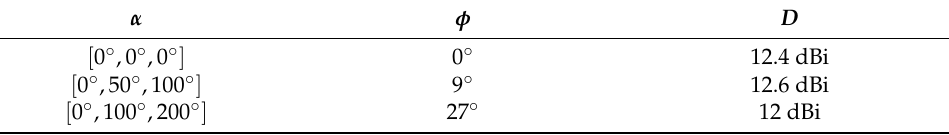
Figure 7. Cut in xy plane of simulated and measured radiation patterns for tested combinations of phases α of excitation signals of equal magnitudes at the frequency of 26 GHz: ( a ) [ 0 ◦ ,0 ◦ ,0 ◦ ] , ( b ) [ 0 ◦ ,50 ◦ ,100 ◦ ] , and ( c ) [ 0 ◦ ,100 ◦ ,200 ◦ ] . Table 1. Tested combinations of phases α with corresponding directivity D and angle φ in the xy plane of the main beam at the frequency of 26